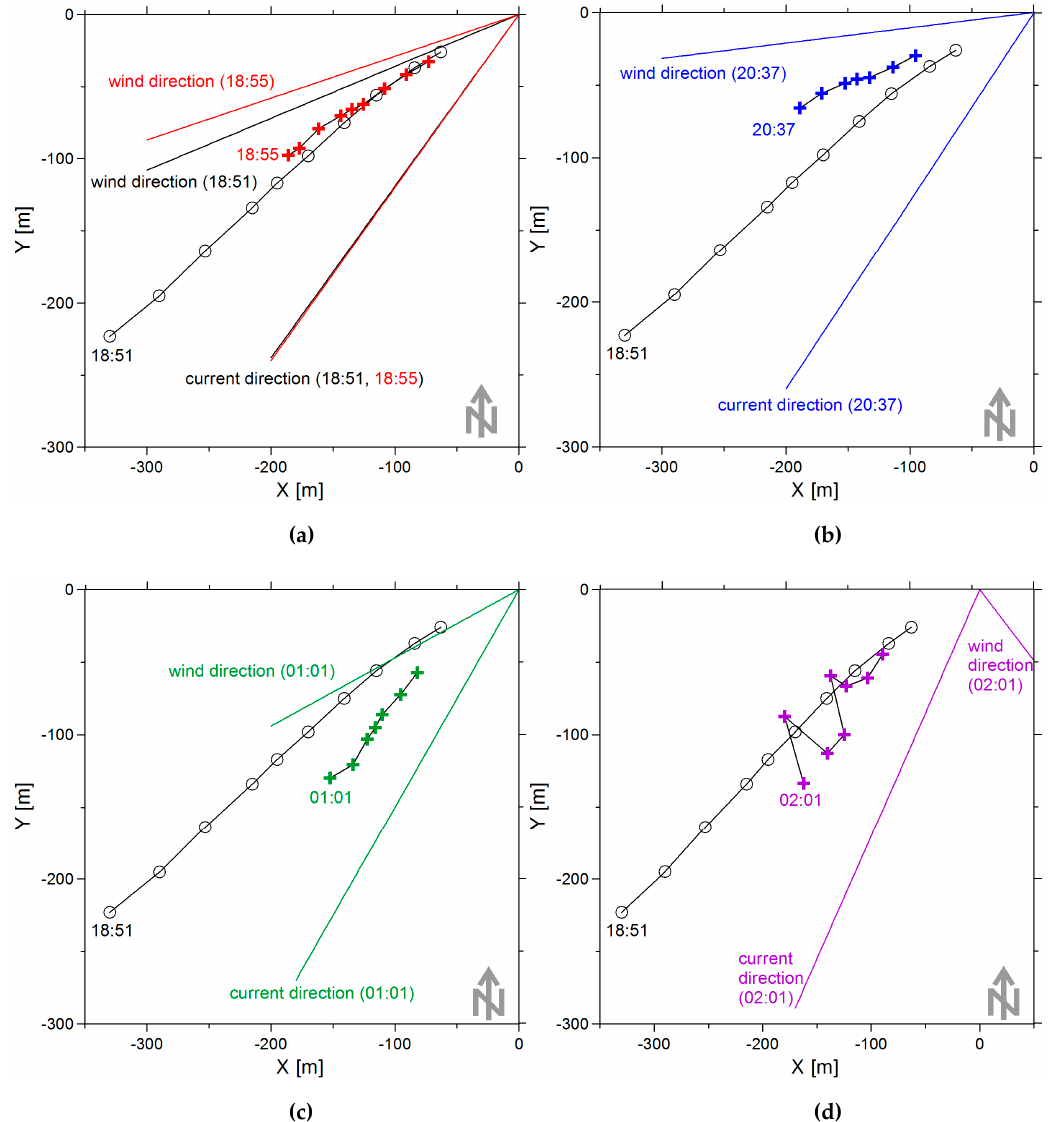
Figure 10. The positions of the slick band at different times relative to the originally formed: ( a ) 18:55, ( b ) 20:37, ( c ) 01:01, ( d ) 02:01. Straight lines denote the sector formed by the directions of wind and current at the time of the image of the slick band.